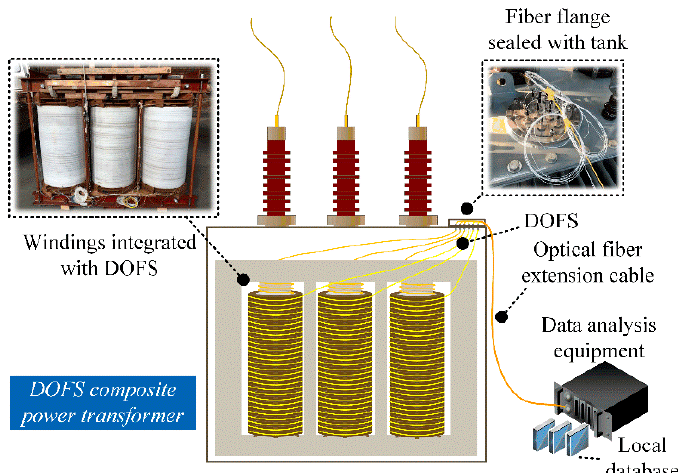
Figure 7. 35 kV power transformer online monitoring platform.